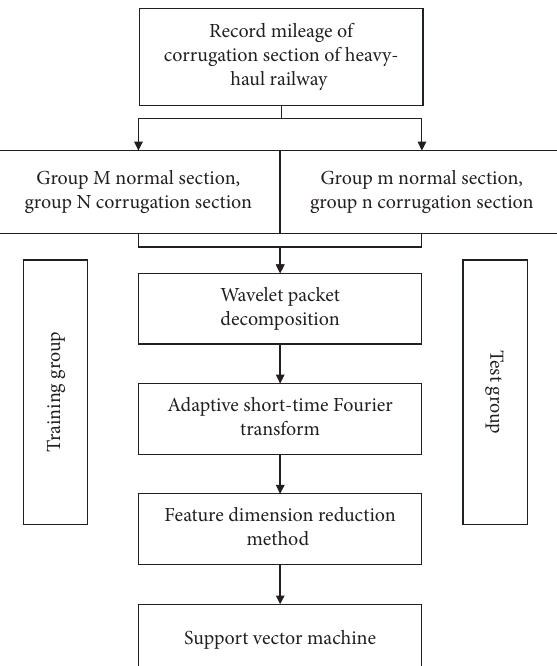
Figure 4: The schematic for the WPD-ASTFT diagnosis method.